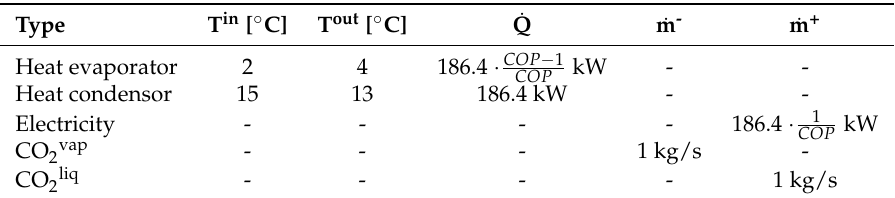
Table A14. Streams for central plant HP (winter).